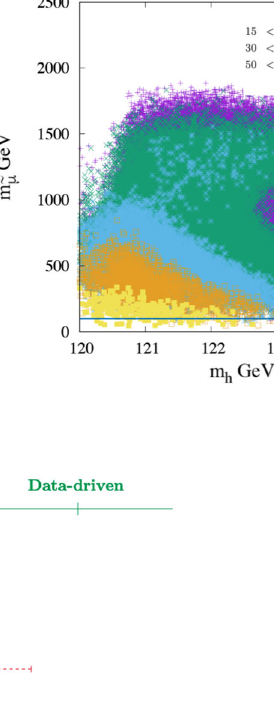
Fig. 2 Scatter plots of flipped SU(5) points in (left panel) the ( m , m ˜ μ ) plane and (right h R ) plane, panel) the (μ, m ˜ μ R color-coded according to the yield, as indicated in the legend. The horizontal lines represent